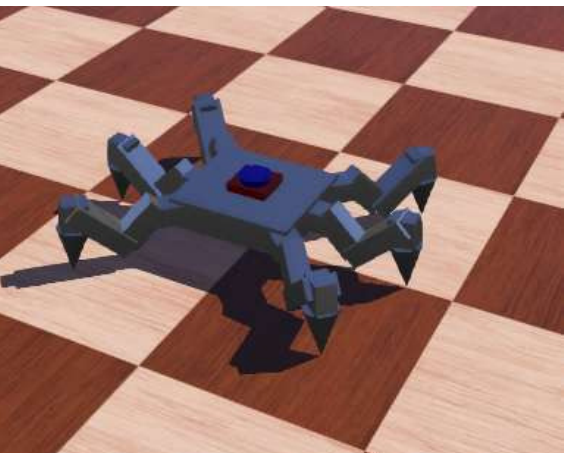
Figure 2. Multi-legged type of virtual agent in Webots. Scales such as for the lengths of the links and the positions of joints and the body are set to be similar to those of an actual robot, as shown in Figure 3. This model is controlled by a Python program in Webots, and information on contact between the ground and the end point of a leg can be obtained in the program.